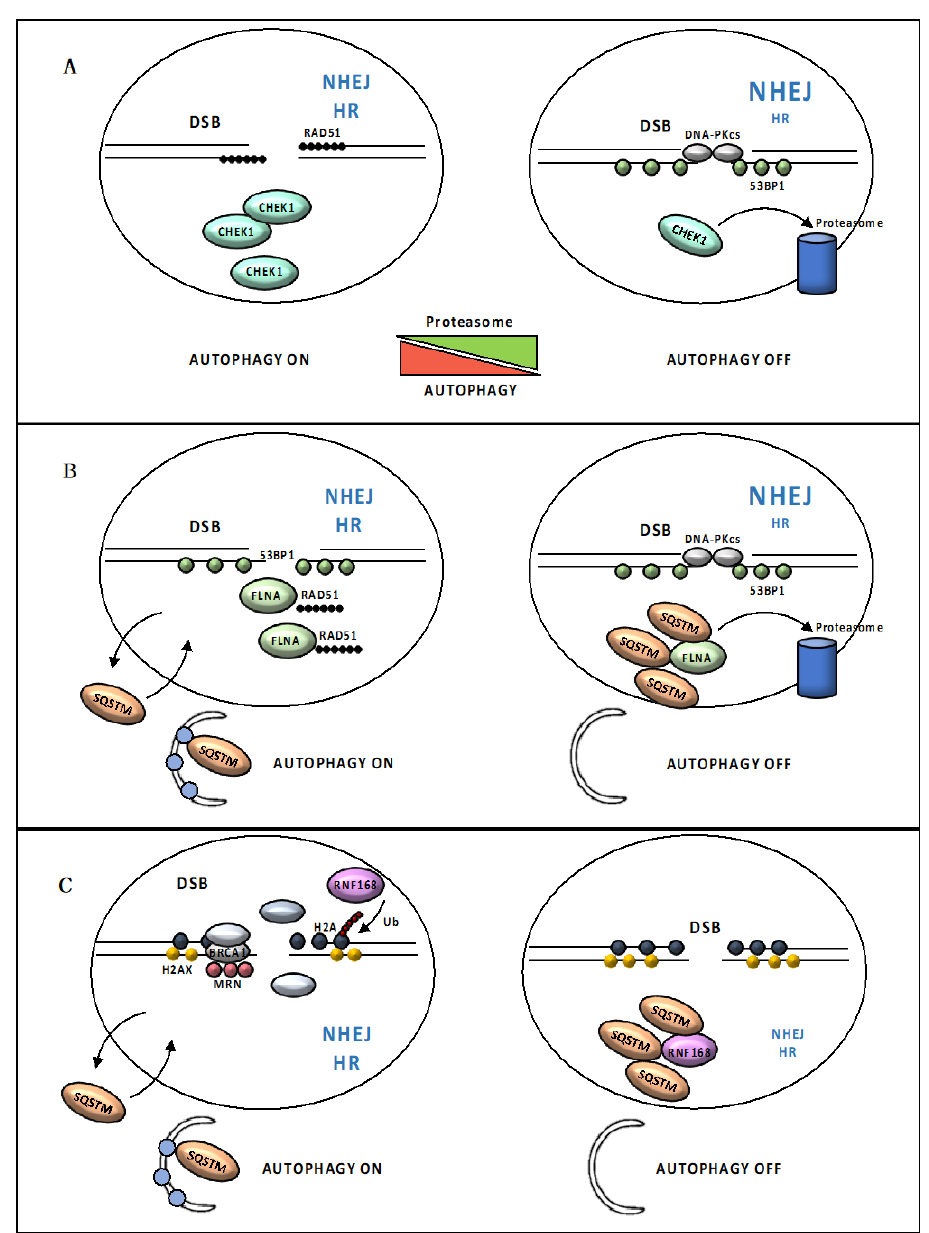
Figure 4. Loss of autophagy impairs DSB repair. ( A ) Autophagy indirectly regulates the CHEK1 (serine/threonine checkpoint kinase 1) levels through inhibition of its proteasome-mediated degradation. Loss of autophagy leads to deficiency in CHEK1 as a result of uncontrolled CHEK1 degradation, compromising RAD51 foci formation and causing HR deficiency. ( B ) Nuclear SQSTM1 targets FLNA (filamin A) and RAD51 for degradation via the proteasome within the nucleus, resulting in reduced levels of nuclear RAD51 and facilitating NHEJ at the expense of HR. ( C ) Increased SQSTM1 levels also suppress the E3 ligase activity of RNF168. RNF168-induced histone polyubiquitination is hampered and results in reduced recruitment of DDR proteins following DNA damage.